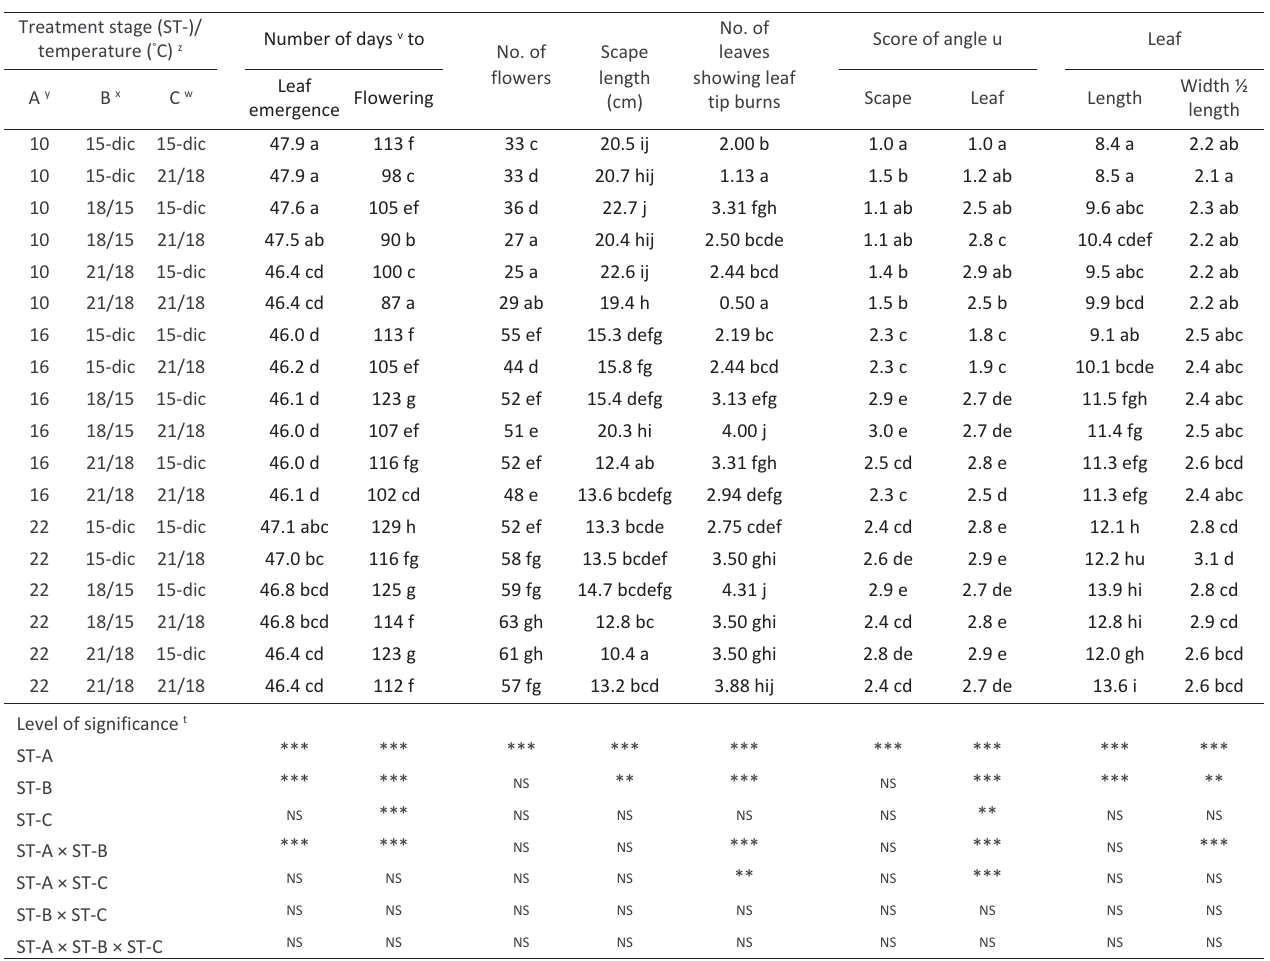
Table 4 ­ The effect of temperature treatment during three different growth and development periods on the growth and flowering of Ornithogalum